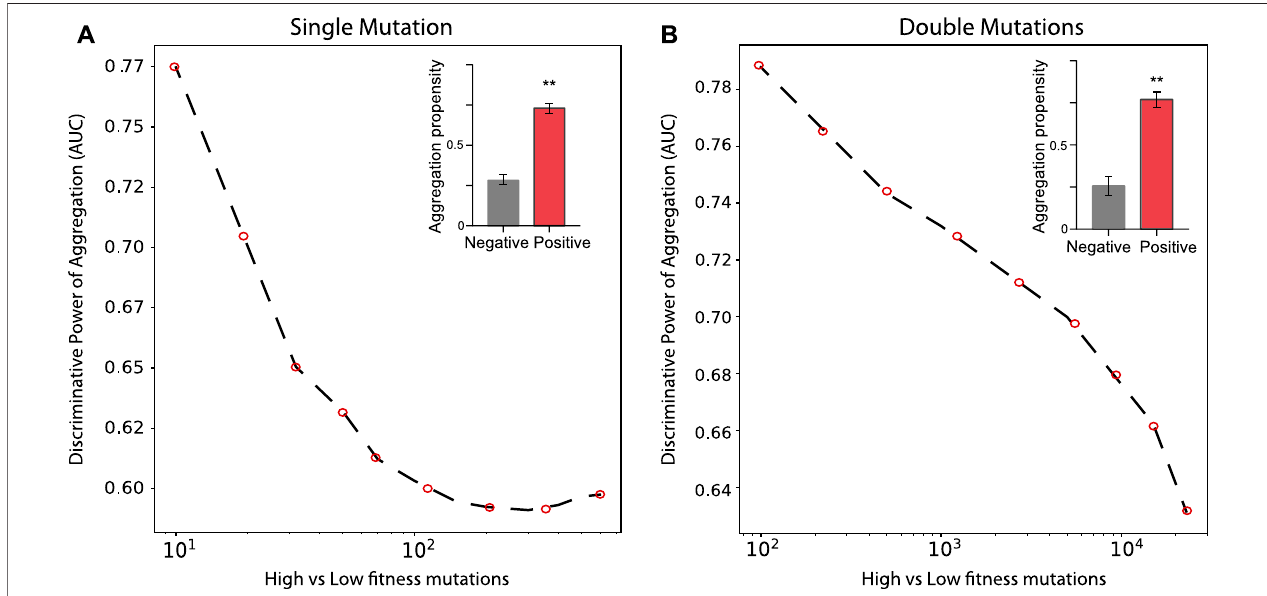
FIGURE3| DeepmutationalscanningexperimentsofTDP – 43mutantsexpressedin S.cervisiae .AUCscorescomputedonthetopandbottomsub-datasets. (A, B) show the rise of the AUC values as function of the high vs low fi tness data sets for single and double mutations, respectively.In the insets, we show the aggregation propensities of mutations associated with the highest (top 100) and lowest (bottom 100) fi tness mutations (**, p -value < 0.01, Kolmogorov-Smirnoff test).